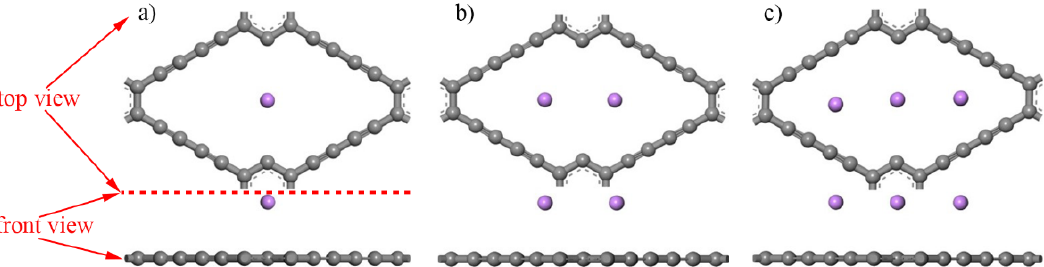
Figure 7. Three initial Li-VGDY models. (Purple ball is Li atom, ( a – c ) represent the Li atoms concentration 1, 2 and 3, respectively). Table 4. Adsorption height and adsorption energy of Li (x) -VGDY.